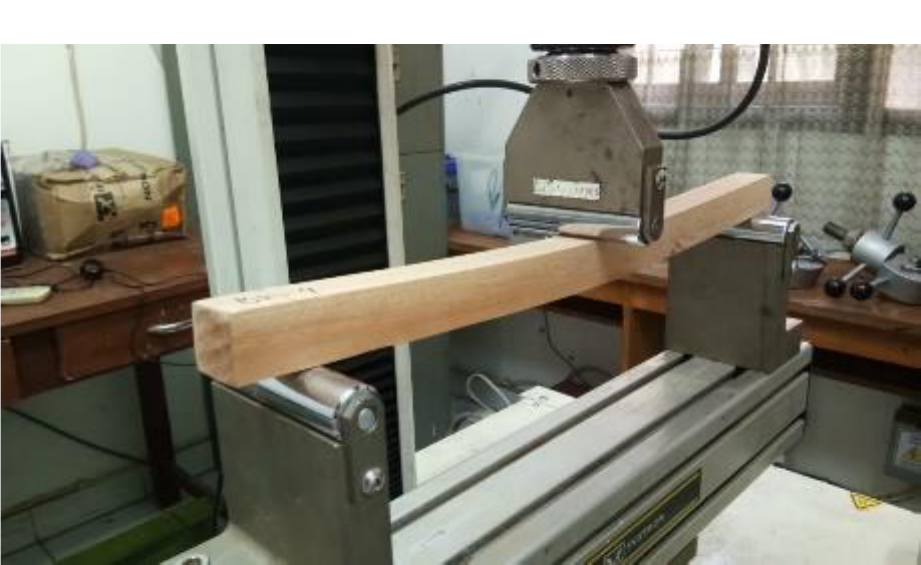
Figure 1. Static bending test of small specimens following the ASTM D143 secondary method [20]. The specimen size was 25 × 25 × 410 mm with the span length of 360 mm and loading speed of 1.3 mm/min.